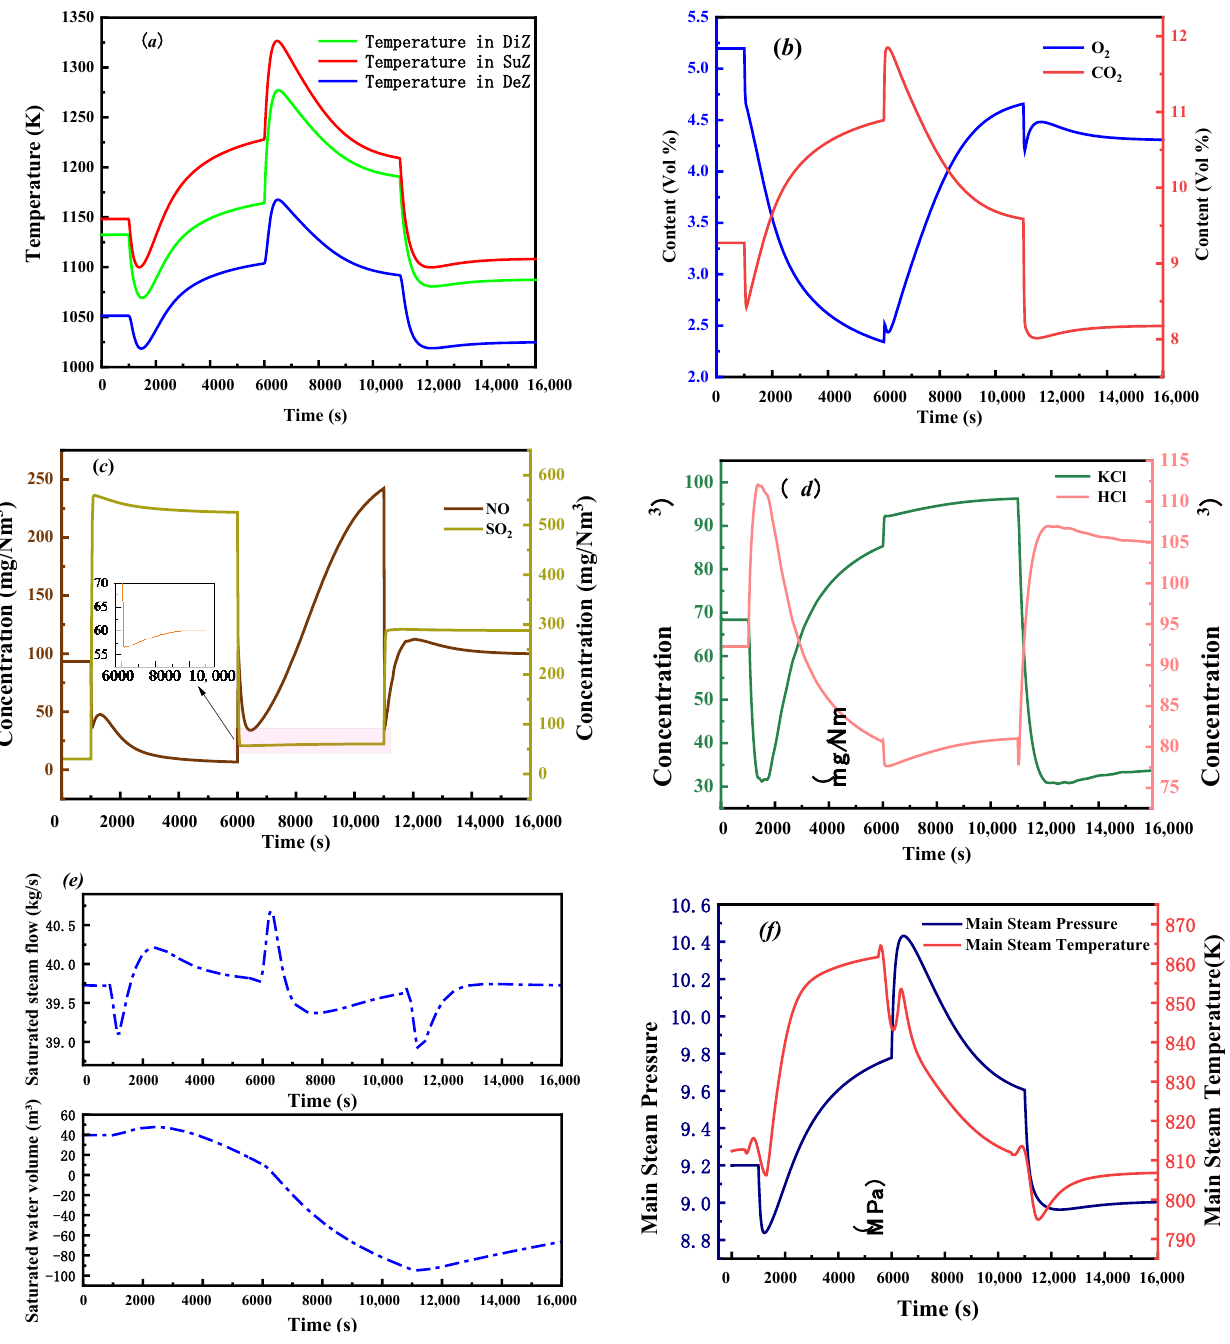
Figure 4. ( a ) furnace temperature response ( b ) O 2 , CO 2 response ( c ) NO, SO 2 response ( d ) KCl, HCl response ( e ) saturated steam flow and saturated water volume response ( f ) main steam pressure and main steam temperature